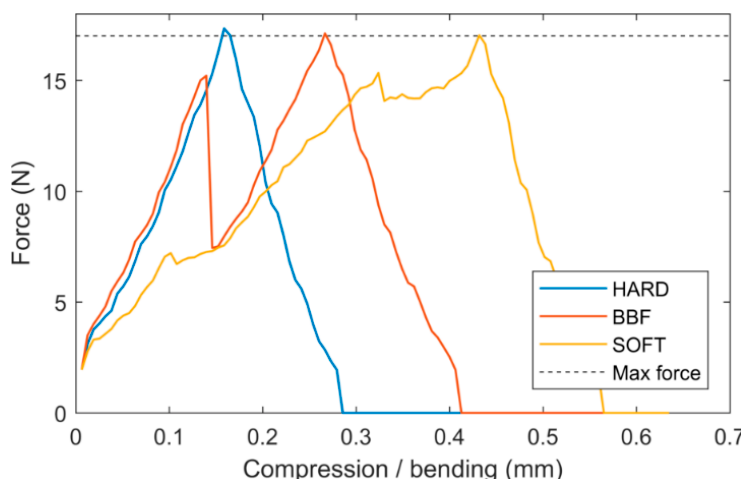
Figure 8 . Example of texture measurement of a Hard kernel, a BBF kernel and a Soft kernel. The x - axis shows compression/bending deformation of the kernel and the y-axis shows the measured force. Note that the Hard kernel requires a high force for a small deformation, whereas the Soft kernel deforms much more before reaching the max force. The BBF kernel broke after 0.14 mm deformation.